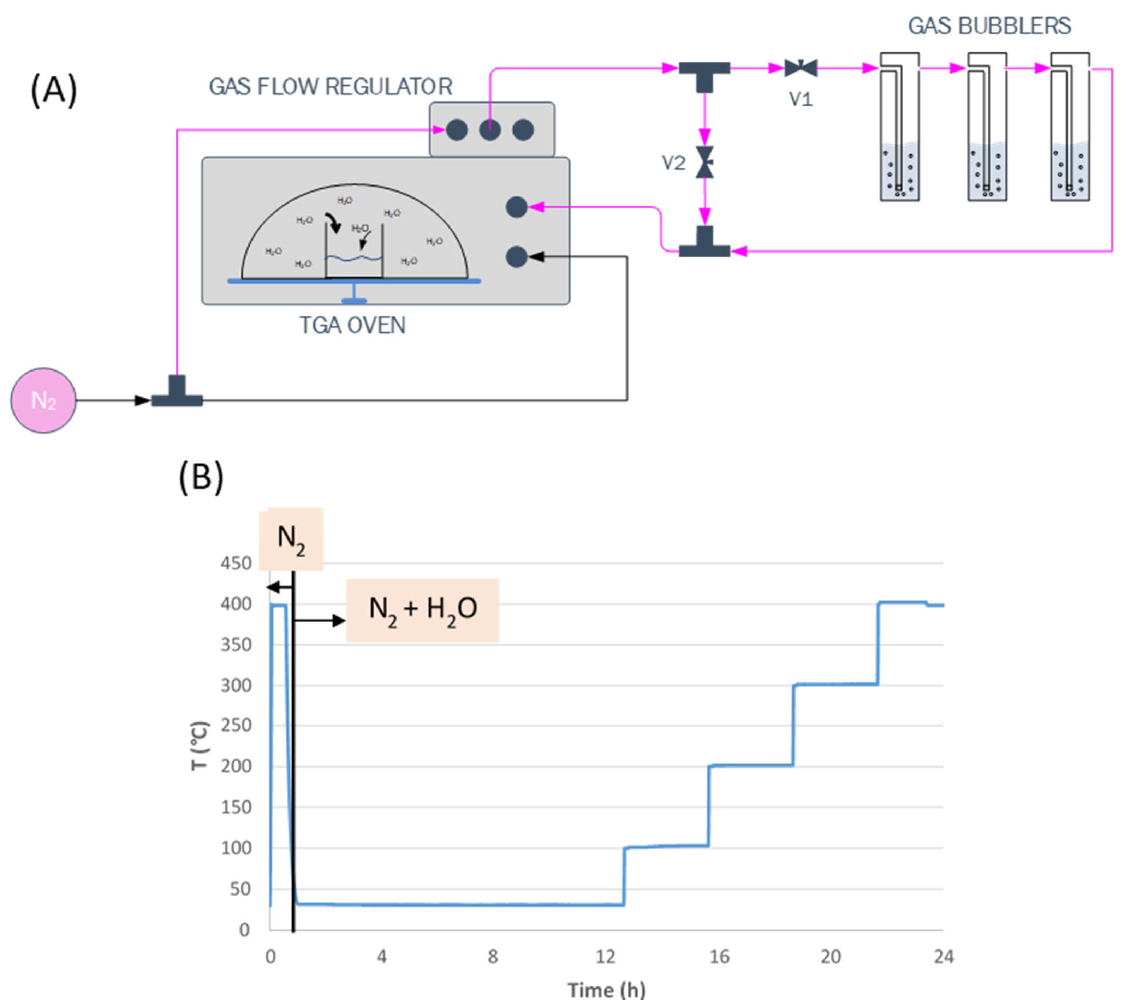
Figure 1. ( A ) Scheme of the experimental design employed for sorption measurements. ( B ) Tempera- ture program employed during the water sorption measurements.